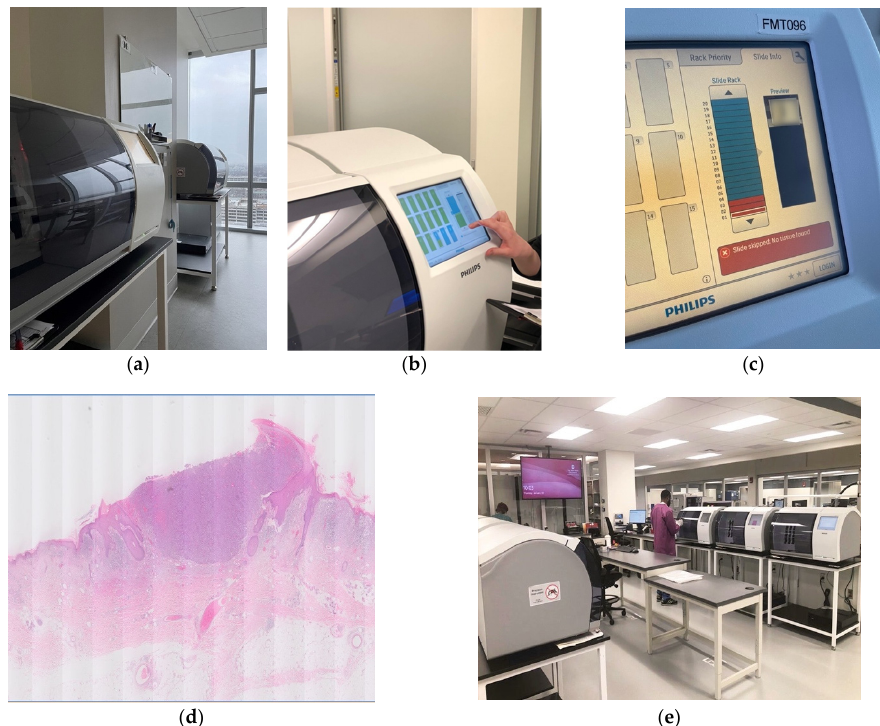
Figure 1. Digital pathology integration at the Ohio State University James Cancer Hospital and Solove Research Institute (captured by David Kellough of The Ohio State University Comprehensive Cancer Center—Arthur G. James Cancer Hospital and Richard J. Solove Research Institute): ( a ) Philips UFS scanners; ( b ) Integrated LCD touchscreen for WSI review; ( c ) Scan failure indicator; ( d ) example of scanning error (“Venetian blinding”); ( e ) Histology laboratory.